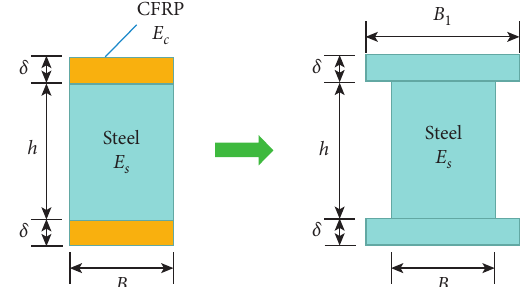
Figure 2: Schematic for calculating the effective stiffness of the composite section using the transformed section method, which transforms the beam into the one made of a single material of steel. B denotes the width of the CFRP-reinforced zone after 1 transformation.